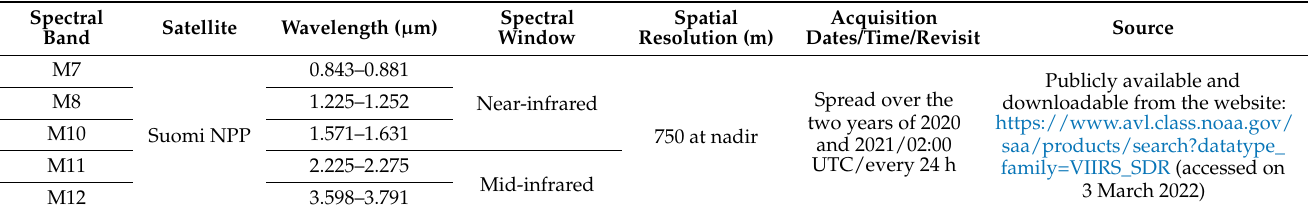
Table 1. The used VIIRS NTL spectral bands covering the considered flare.